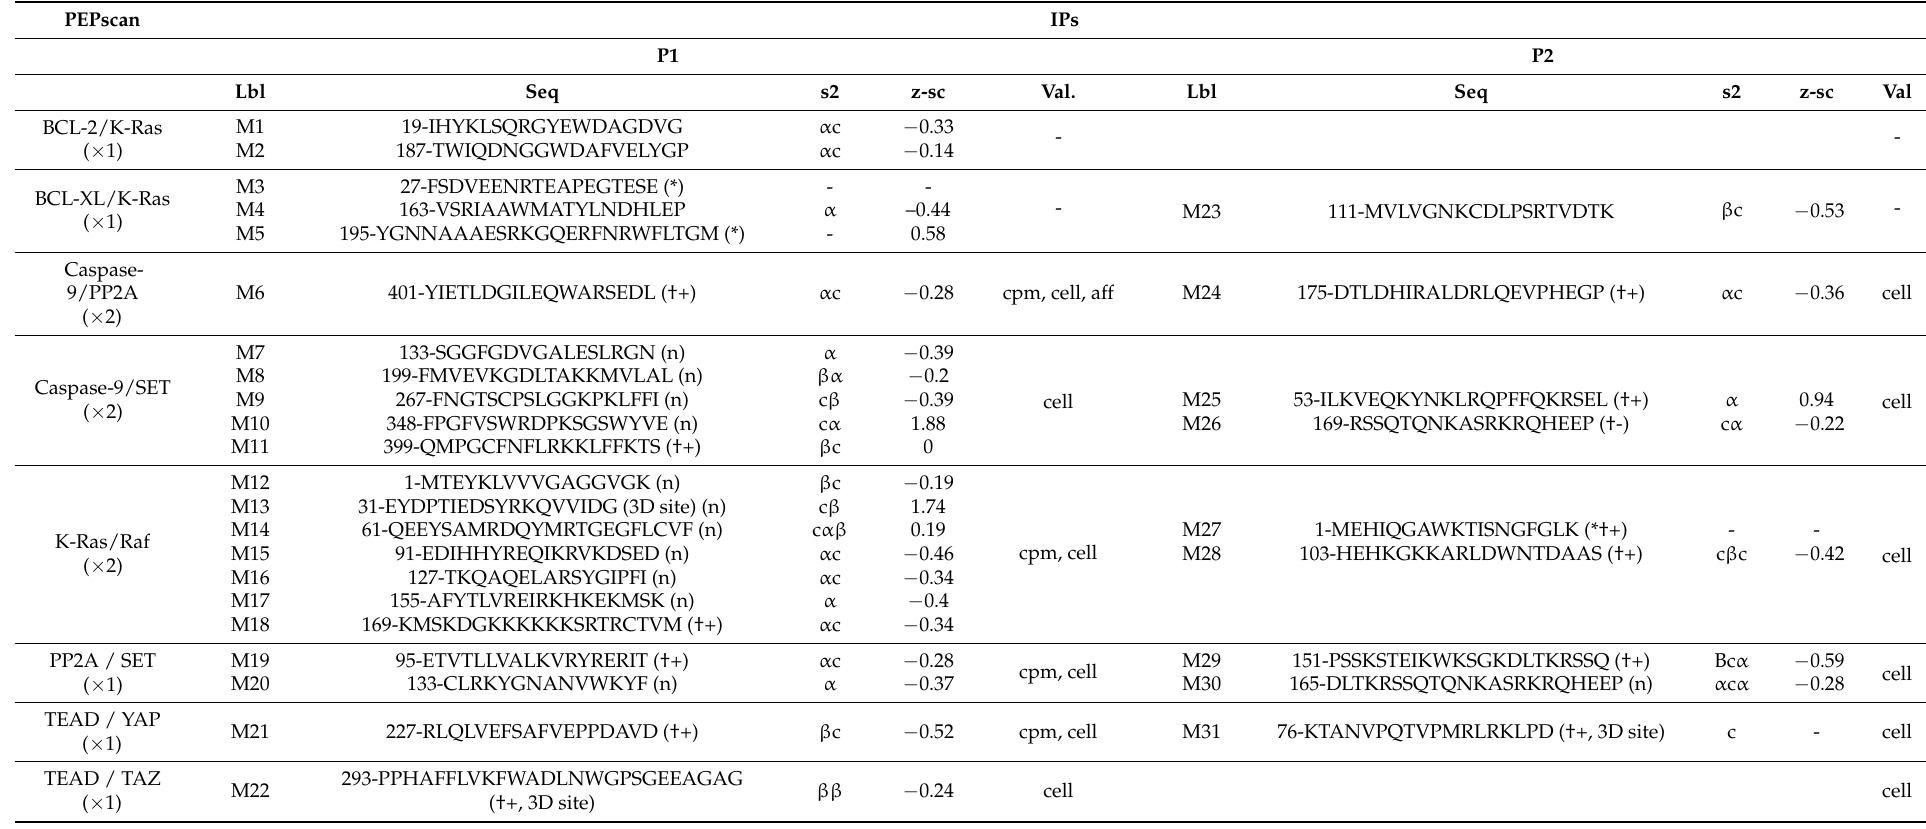
Table 2. IPs identified by PEPscan.